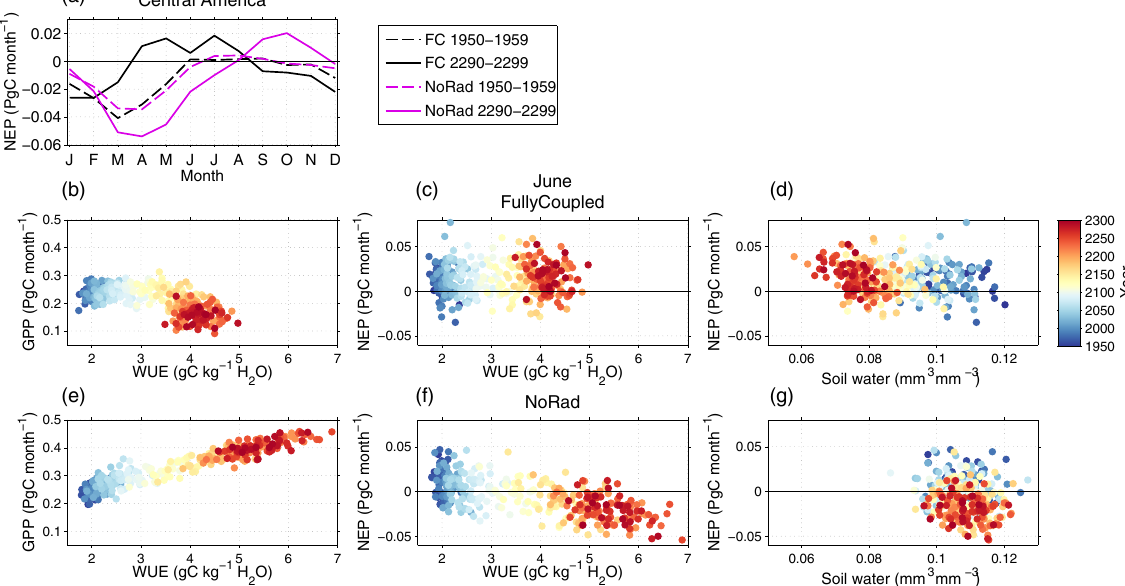
Figure 15. (a) Mean annual cycles of NEP in Central America averaged over 1950–1959 and 2290–2299 in the FullyCoupled (black dashed and solid lines) and NoRad (magenta dashed and solid lines) simulations. (b, e) GPP as a function of WUE, (c, f) NEP as a function of WUE, and (d, g) NEP as a function of volumetric soil water in the top layer (0.71cm depth) in the month of June over Central America in the (b–d) FullyCoupled simulation and (e–g) the NoRad simulation. NEP < 0 indicates net carbon uptake by